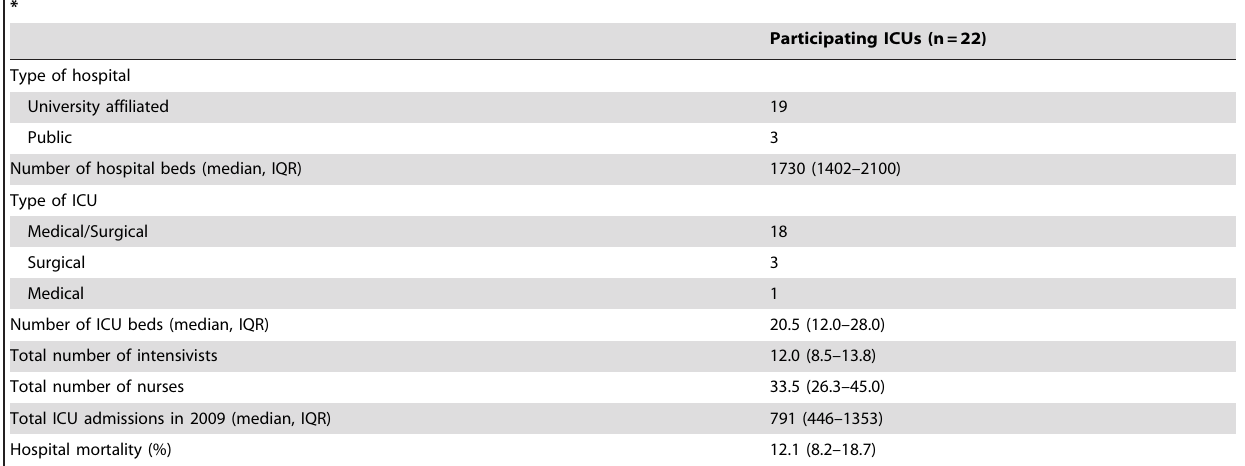
Table 1. Characteristics of participating ICUs.